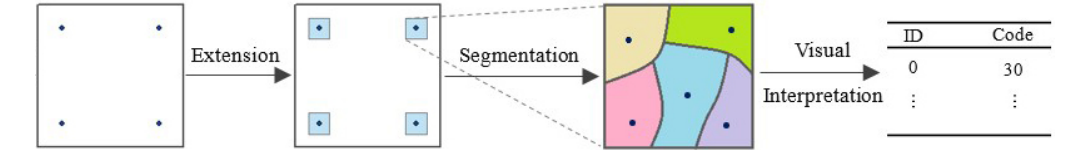
Figure 3. Workflow of the object-oriented sampling.